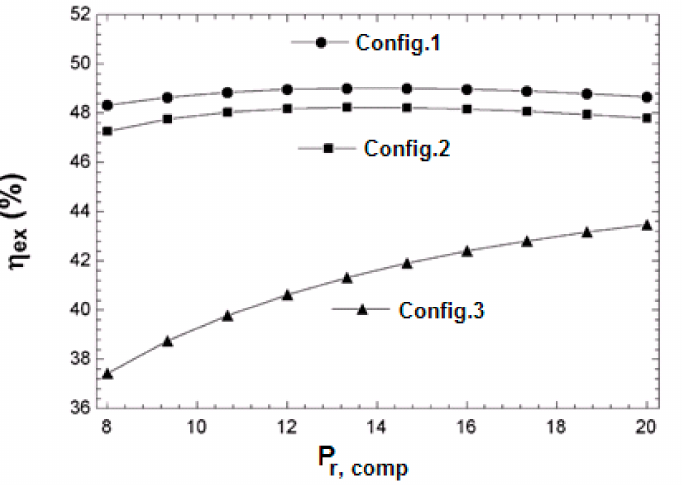
Figure 5. Effect of compressor pressure ratio change on the overall exergy efficiency.